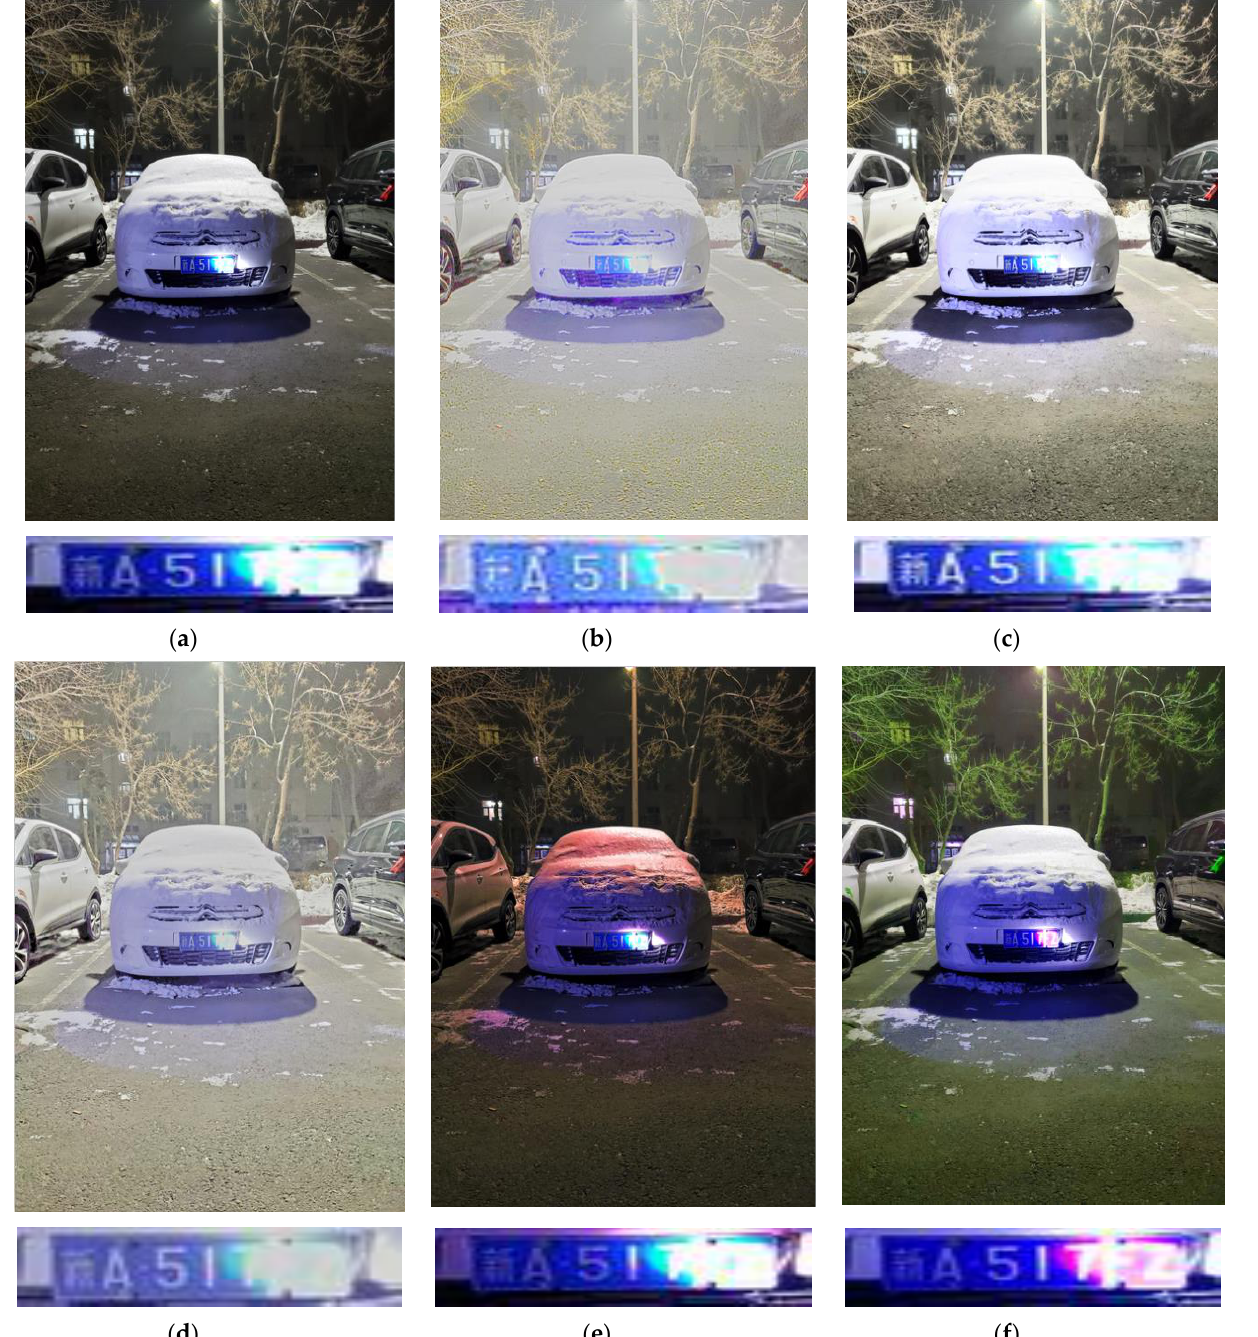
Figure 5. Experimental results: ( a ) original image, ( b ) Hui [35], ( c ) Khan [36], ( d ) Liang [21], ( e ) Xin [37], ( f ) proposed.